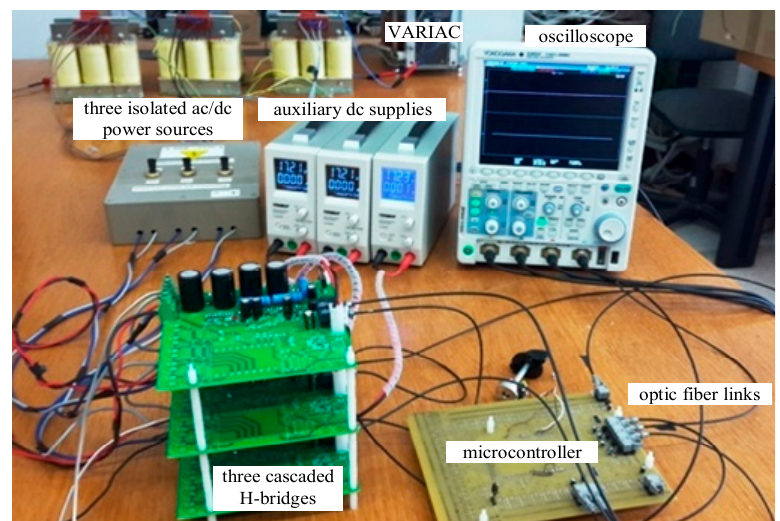
Figure 9. Experimental workbench.